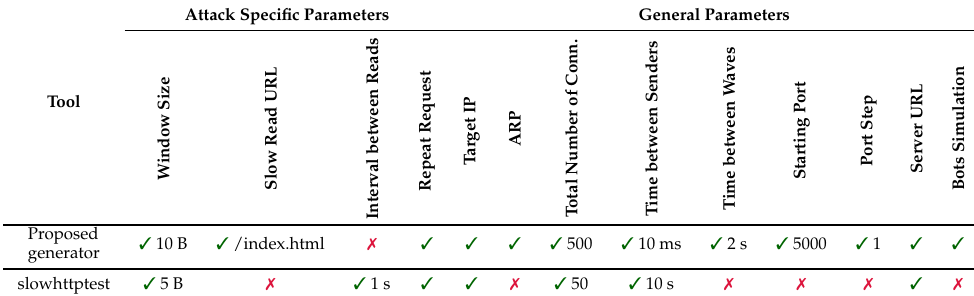
Table 4. Comparison of the proposed generator from the Slow READ attack point of view. Attack Specific Parameters General